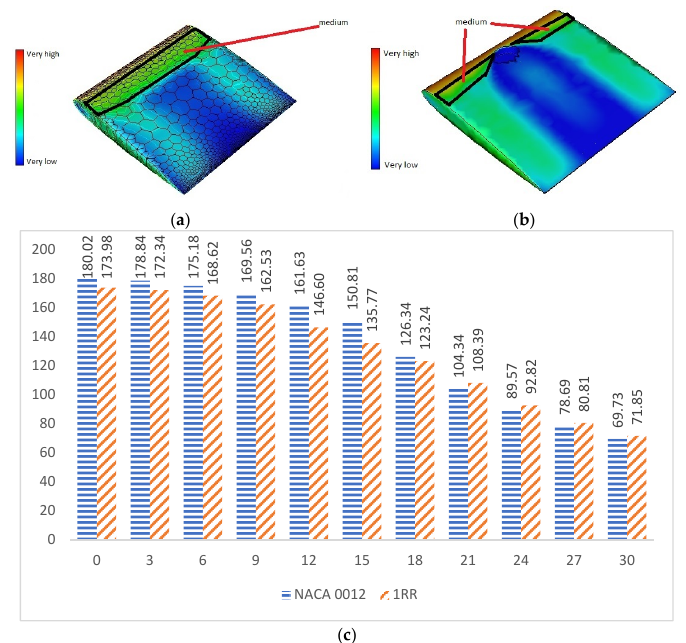
Figure 3. Lift analysis. ( a ) Pressure pathlines of NACA 0012. ( b ) Pressure pathlines of 1RR HPBA. ( c ) Lift generated at all angles of attack. ( d ) Lift increment in percentage.